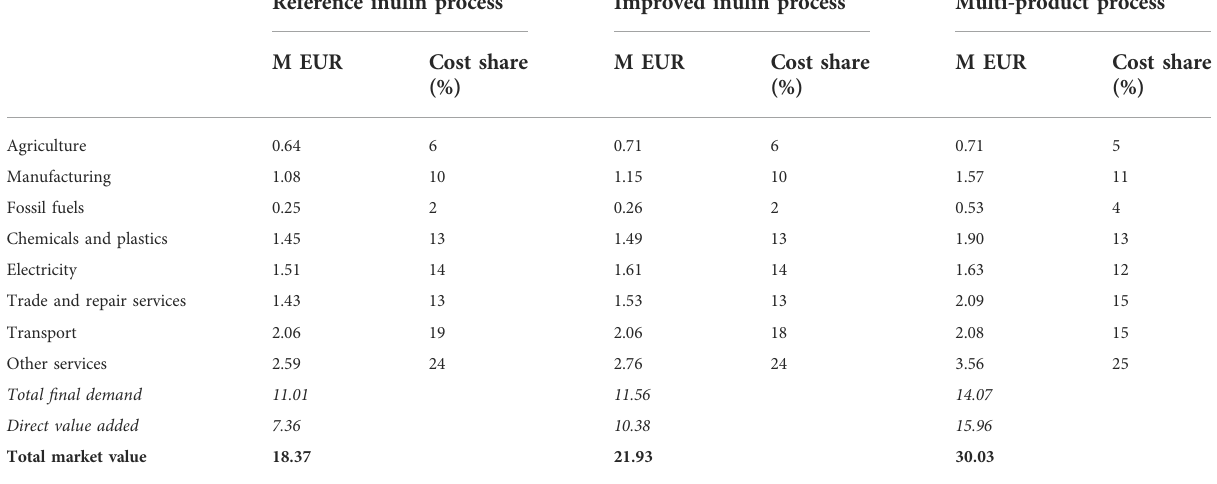
FIGURE 2 System boundary of the scenarios in the LCA.